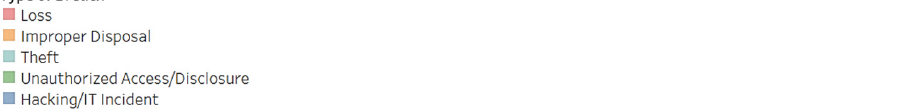
Figure 13. Accumulated records trend vs. accumulated affected number of individuals trend (colored by data breach type).